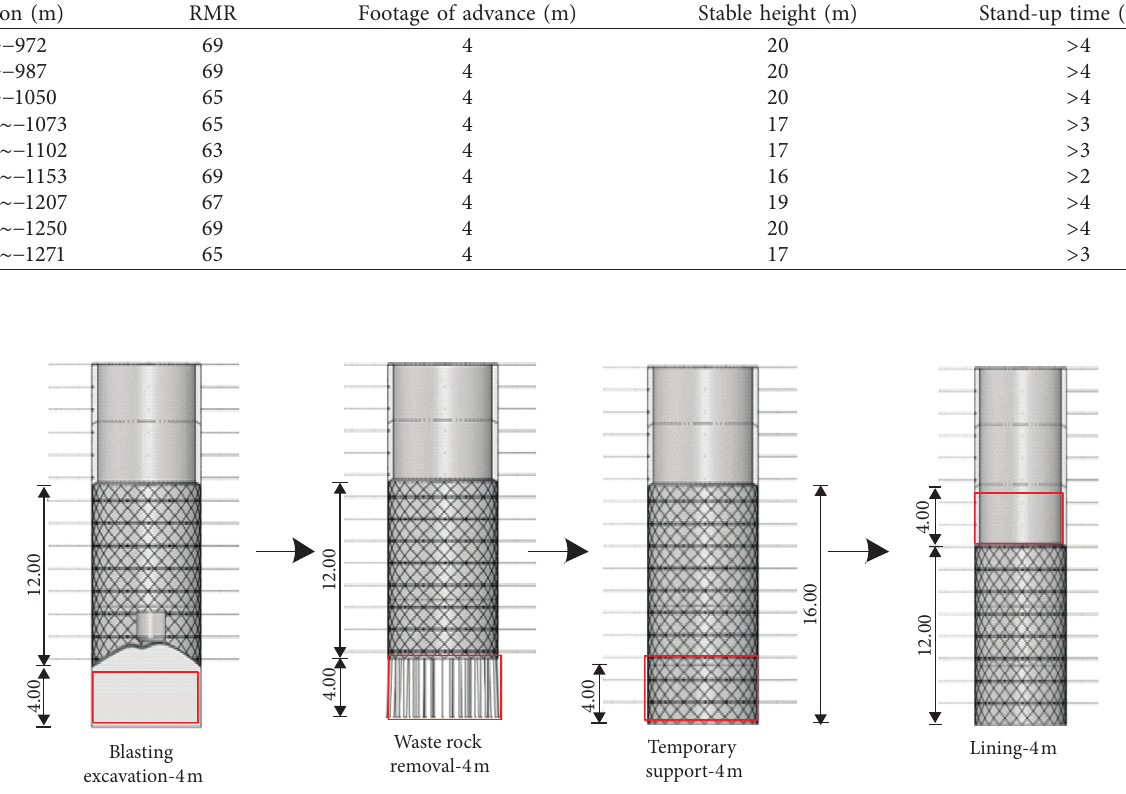
Figure 13: Construction process of the shaft using energy prereleasing